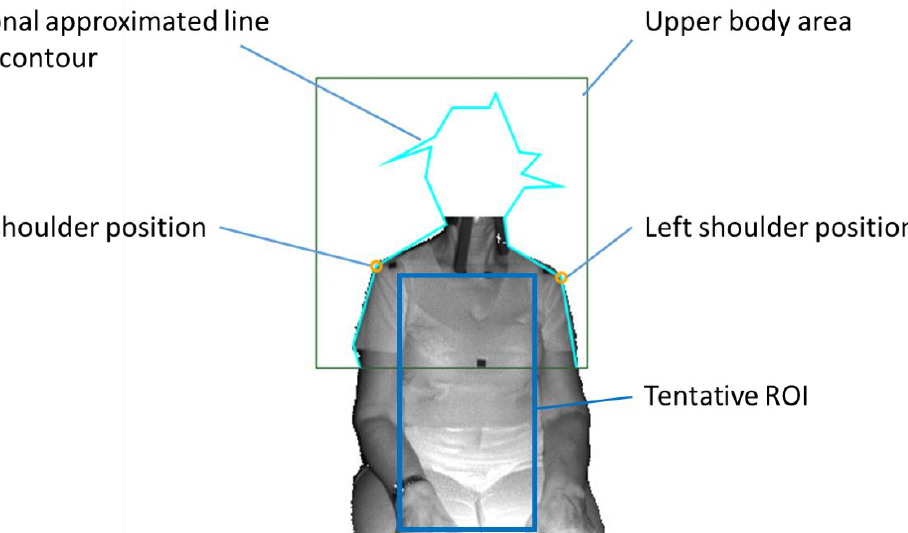
Figure 2. The tentative region of interest (ROI).